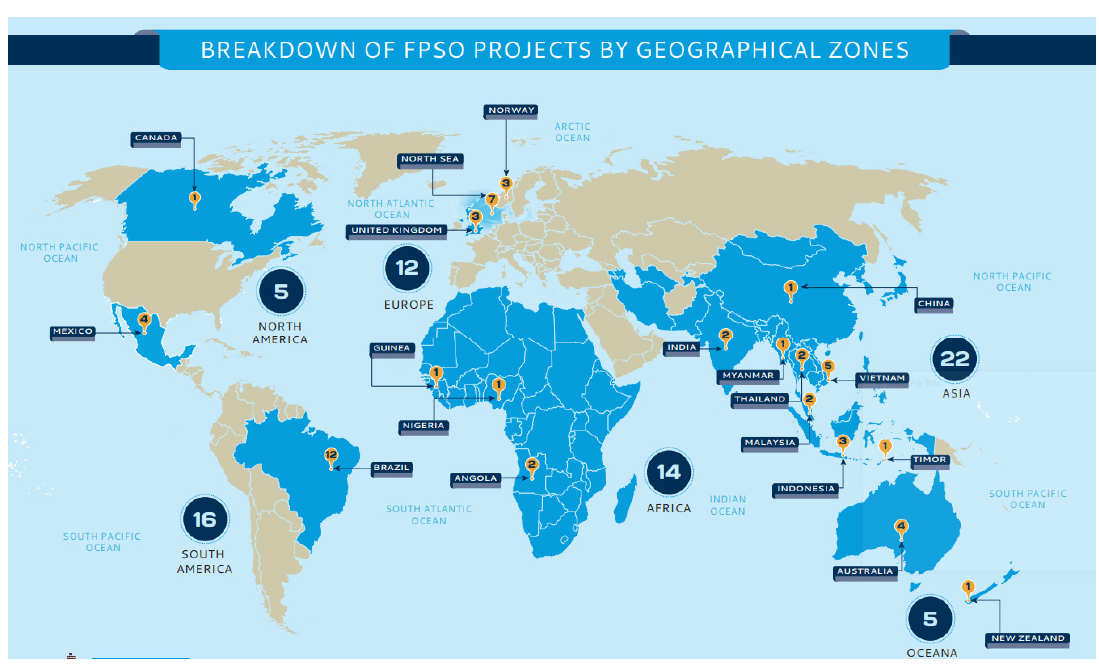
Figure A2. Map of breakdown of FPSO projects by geographical zones, showing various assets that are monitored; from FPSO Asia as of 2013 .